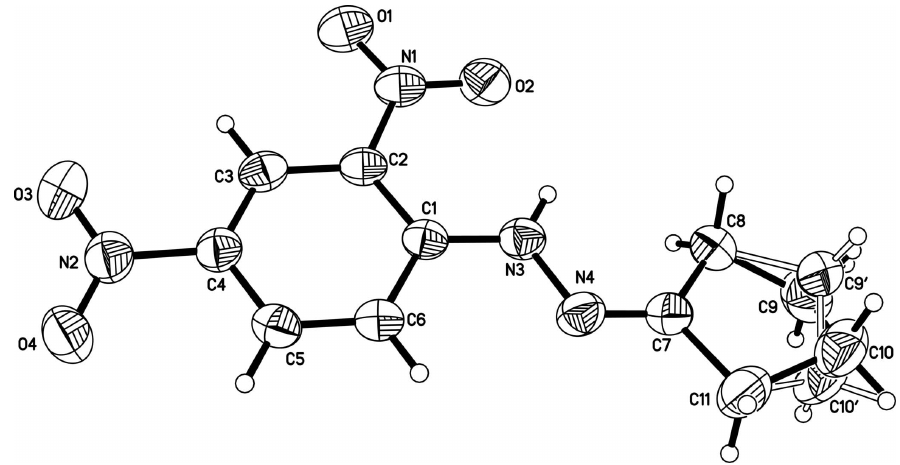
Figure 1 The title molecular with displacement ellipsoids drawn at the 50% probability level.